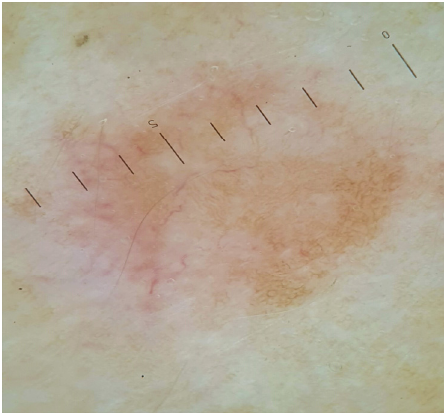
Figure 2. Dermoscopy showed a central hypopigmented area with a peripheral delicate hyperpigmentation and some erythematous arceiform areas with ectatic vessels.